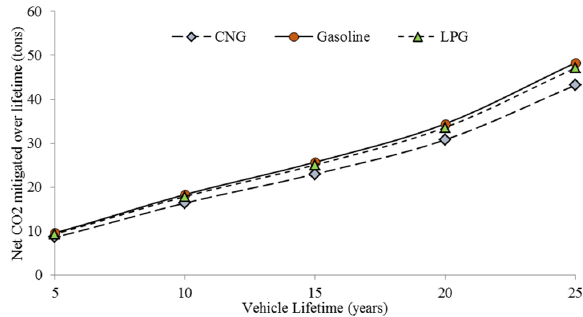
Figure 8. Mitigation of carbon-dioxide emission over SPEA lifetime.